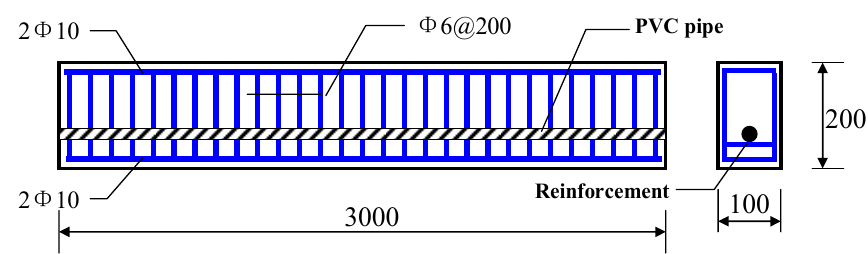
Figure 7. Reinforcement of the beam (unit: